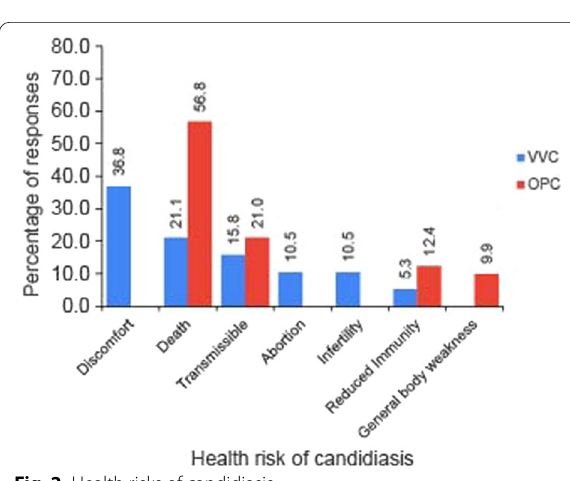
Fig. 2 Health risks of